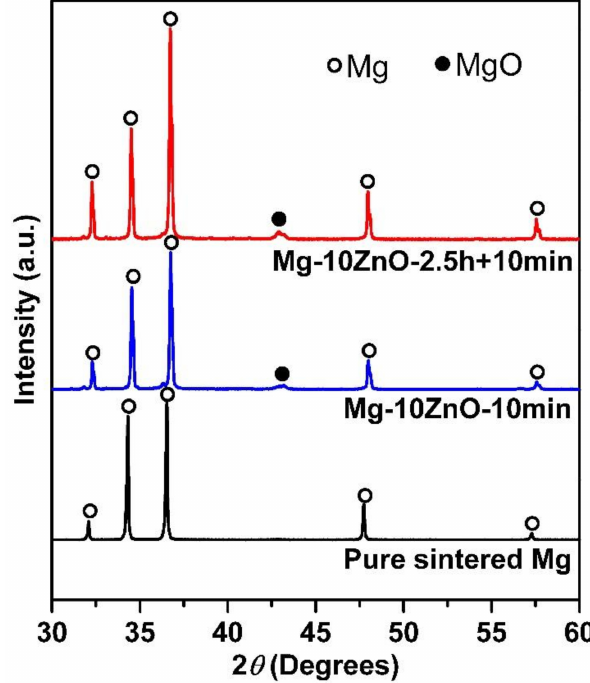
Figure 1. XRD patterns of sintered